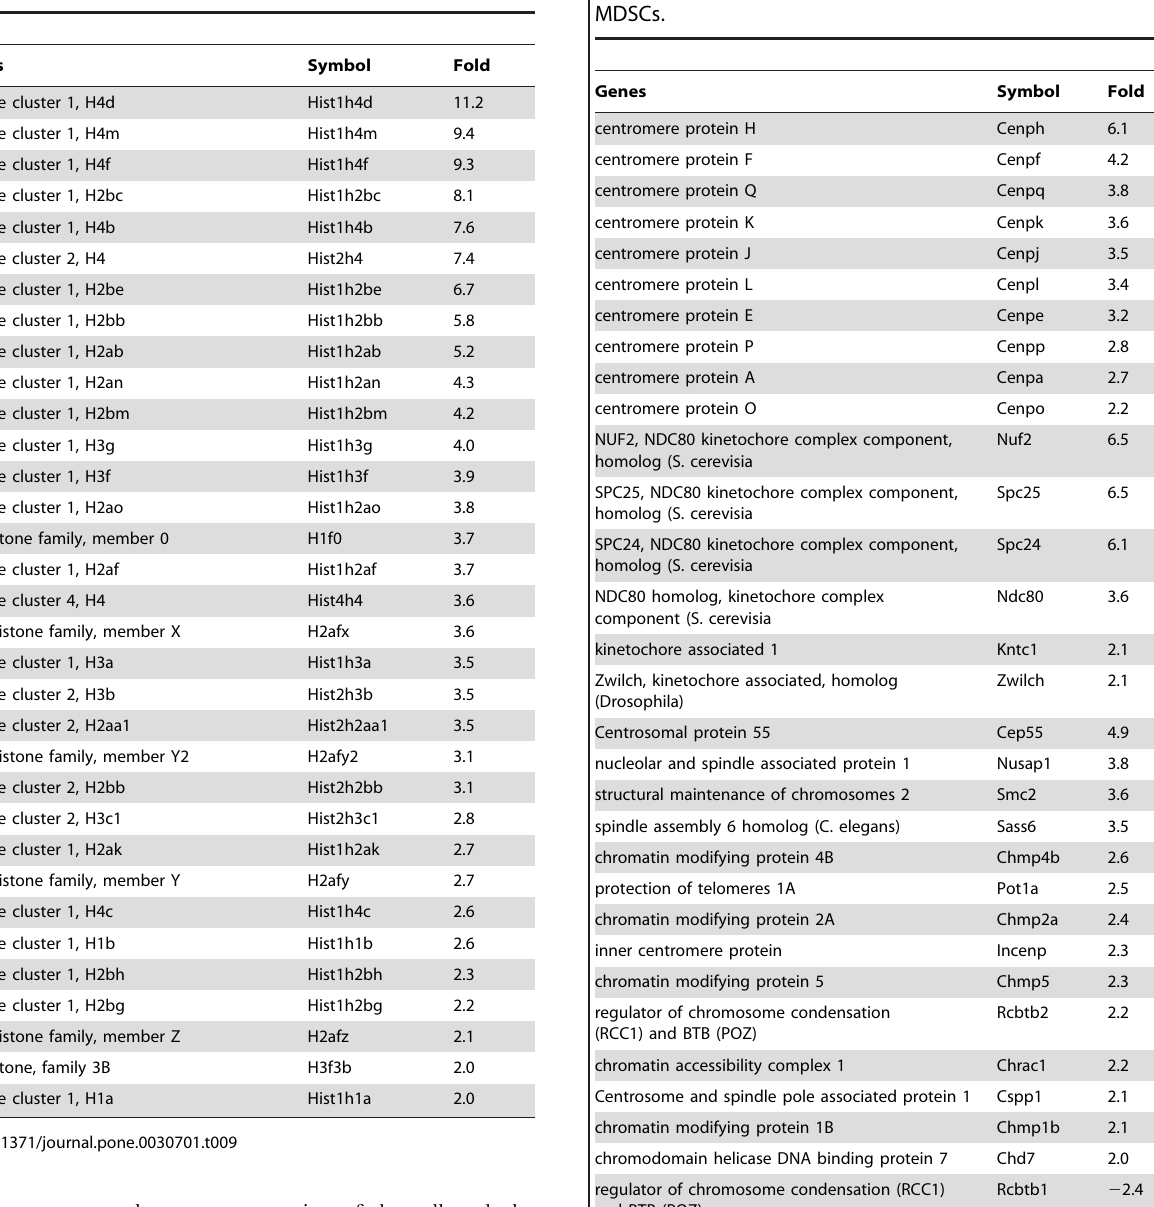
Table 9. Up-regulation of histone cluster genes in lal 2 / 2 bone marrow MDSCs.